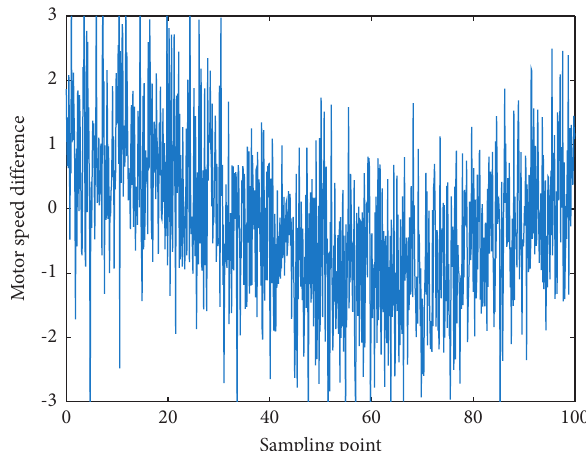
Figure 3: Bar graph of residual speed of wind turbine